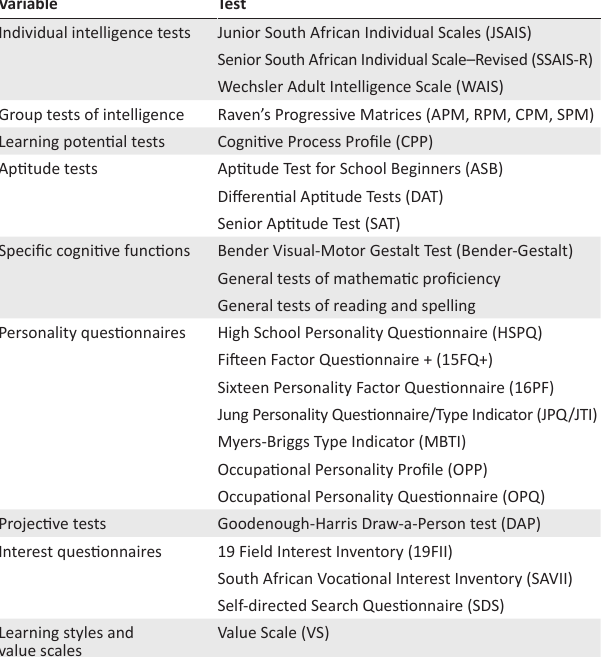
TABLE 3: Tests generally included in the practical training according to